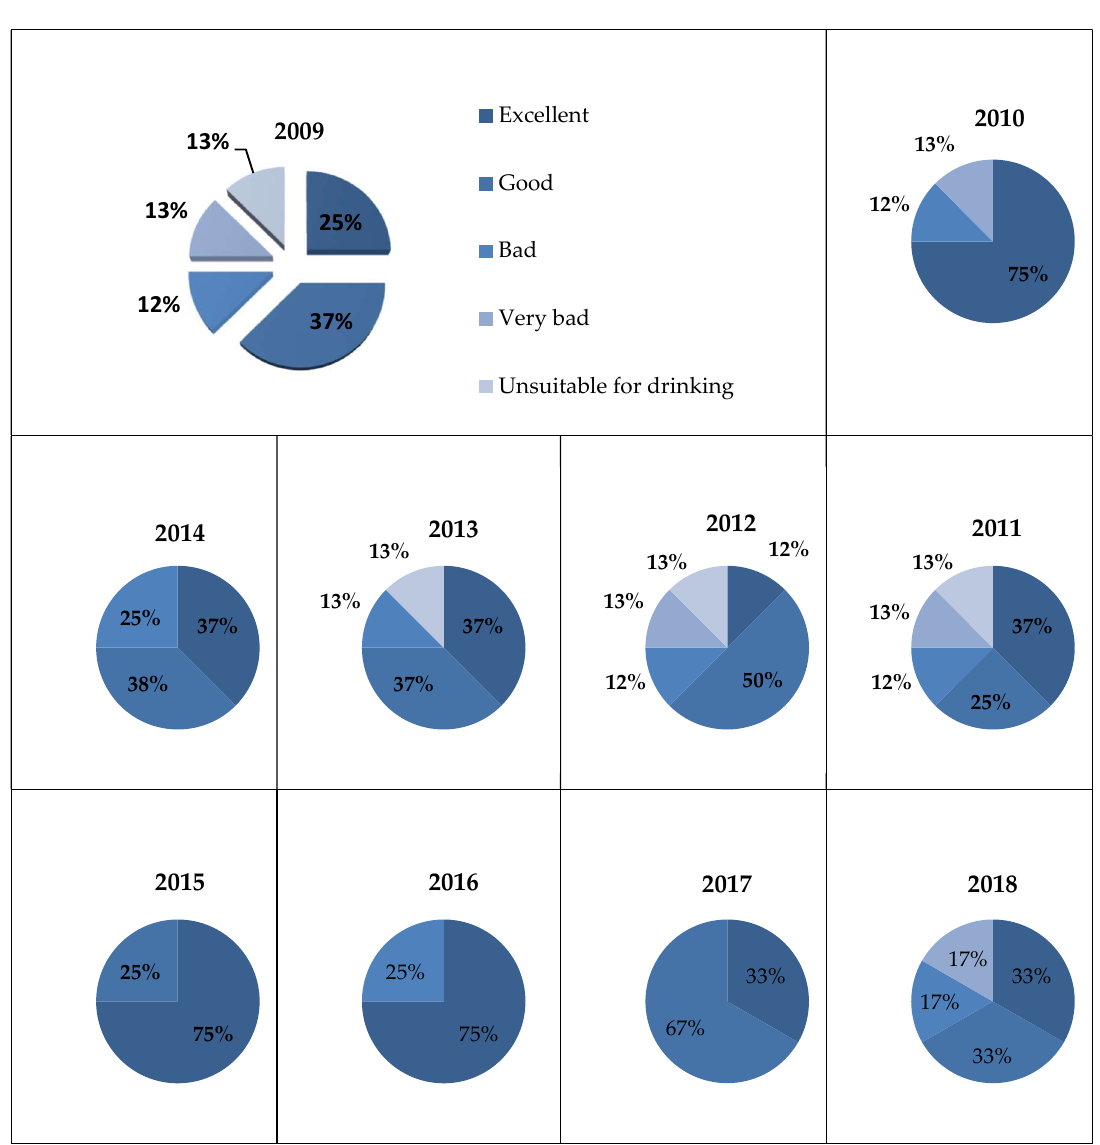
Figure 5. The average of GWQI units of eight wells in the dry season, during 2009–2018.